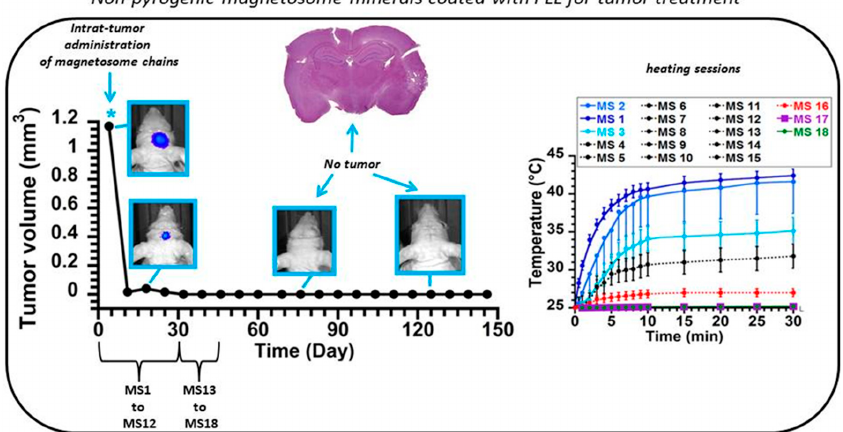
Figure 3. Treatment of a mouse bearing an intracranial GBM tumor of 1.5 mm 3 , which receives at the center of its tumor 500–700 µ g of M-PLL, followed by 27 applications of an alternating magnetic field of 27 mT and 200 kHz, each session lasting for 30 min, and resulting in moderate temperature increase of 0 to 18 ◦ C. The decrease of tumor volume down to 0 mm 3 10 days following the beginning of the treatment as well as the absence of tumor in histological analysis of treated tumor brain slides collected 75 days and 125 days following the beginning of the treatments reveal the full tumor disappearance induced by the treatment. “reproduced with permission in a slightly di ff erent format from Biomaterials, V. 262, P. 259-272 (2017)”. Int. J. Mol. Sci. 2020 , 21 , x FOR PEER REVIEW